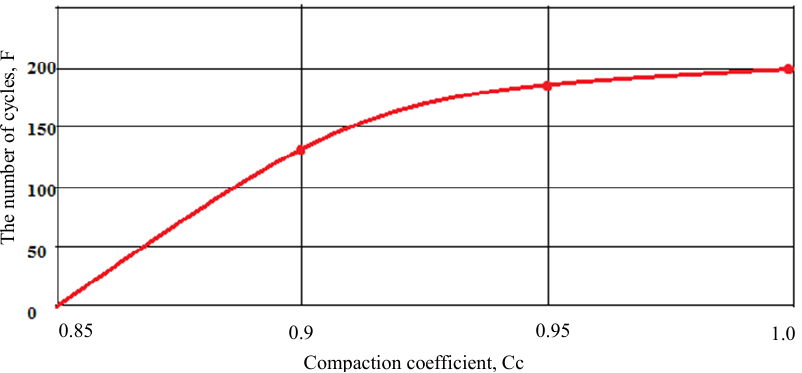
Fig. 2. Dependence of concrete strength on the degree of its